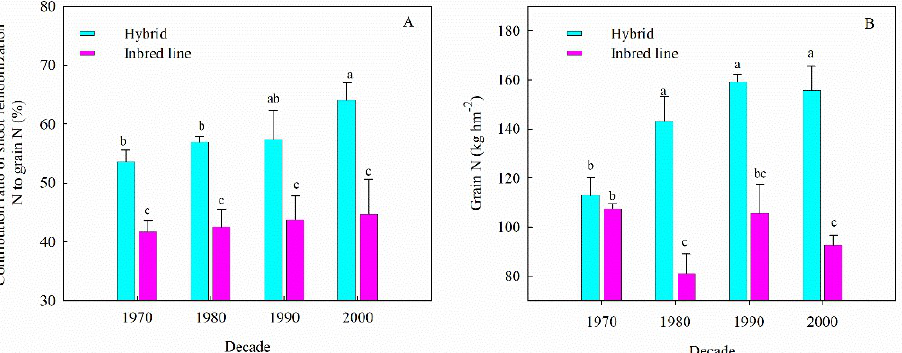
Figure 5. Contribution rate of nitrogen contribution ratio and grain nitrogen content of maize hybrids and inbred lines in different decades. Note: ( A ) Contribution rate of nitrogen contribution ratio; ( B ) grain nitrogen content. Different letters in the same nitrogen treatment indicate significant differences at 0.05